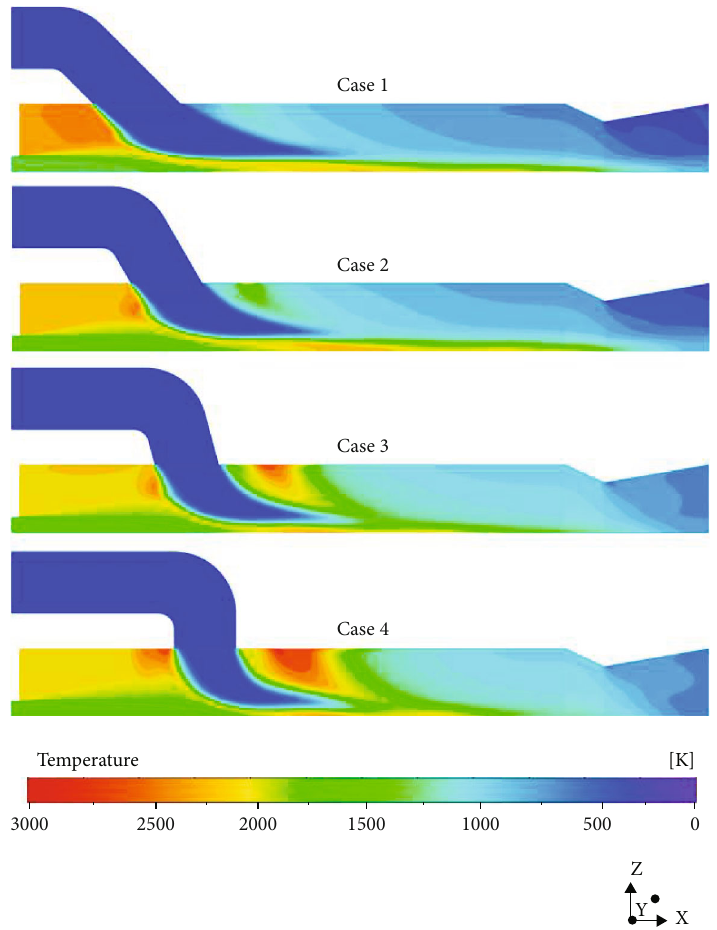
Figure 9: Temperature distribution on axial symmetrical sections of